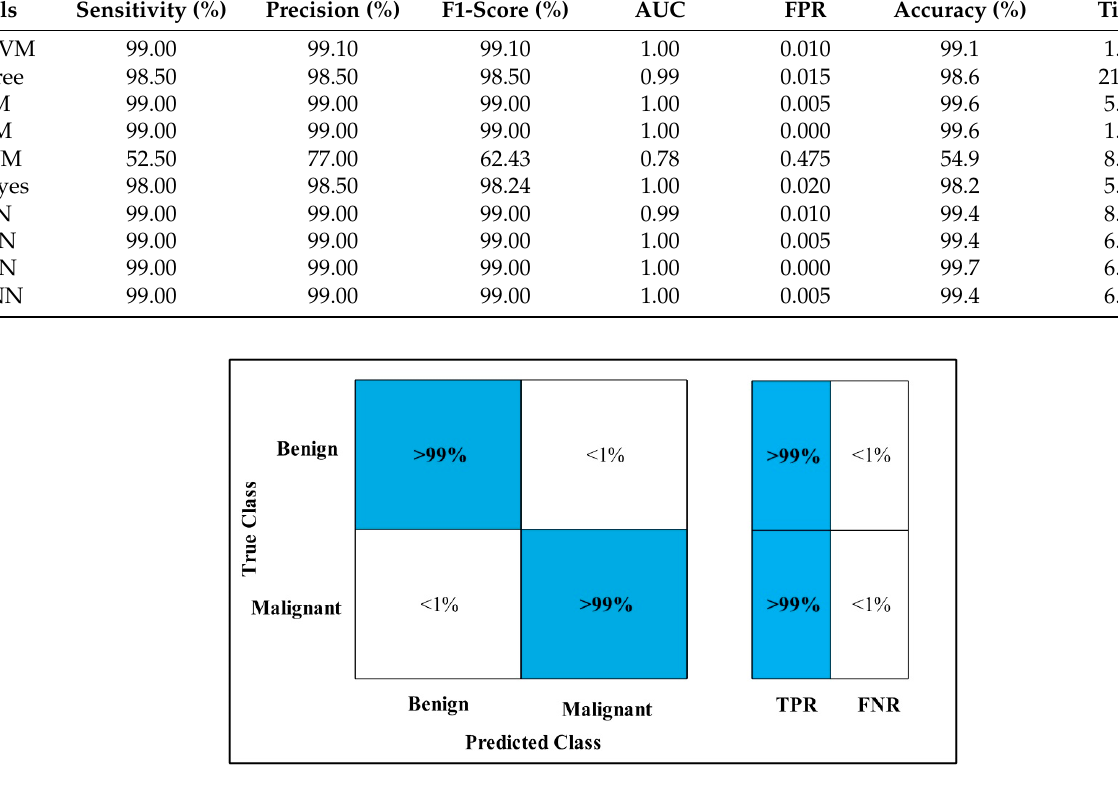
Figure 26. MEWOA on Fusion TPR INbreast.